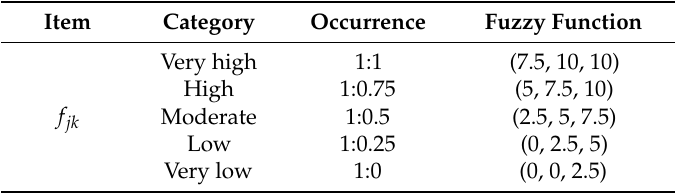
Table 10. Structural / job risk occurrence frequency fuzzy